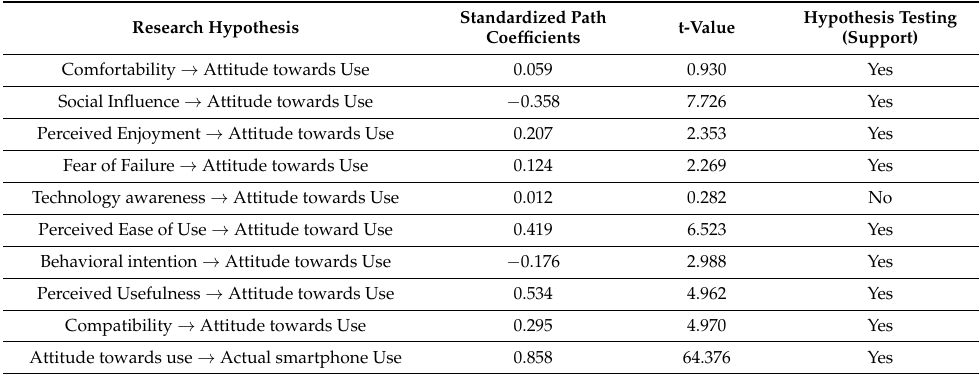
Figure 3. Hypothesis results on construct model . Table 2. Research hypotheses, t-values, path coefficients, and hypothesis